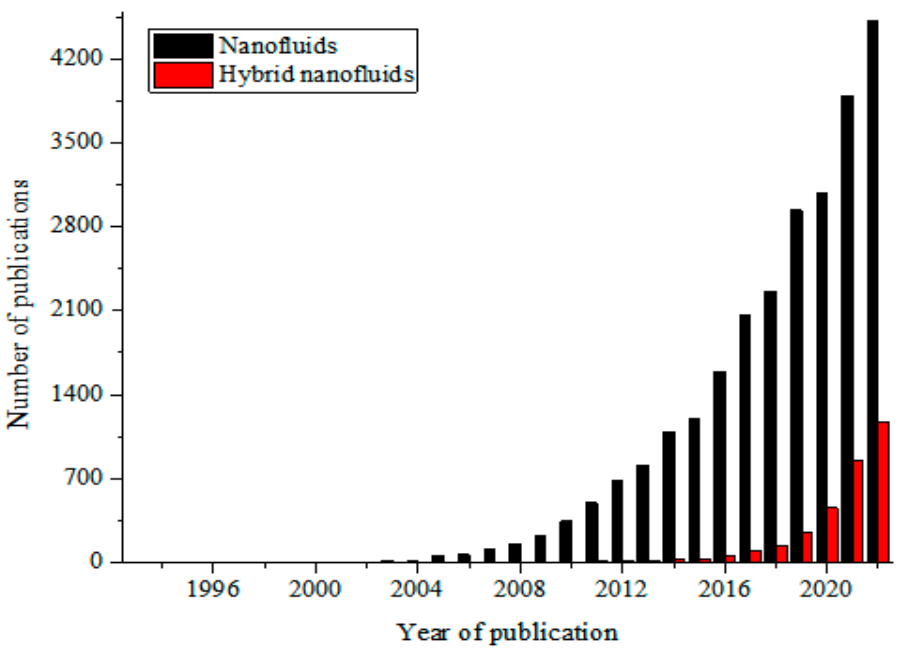
Figure 1. Temporal publication trend of articles on nanofluid and hybrid nanofluid studies (Source: SCOPUS (26 December 2022)).